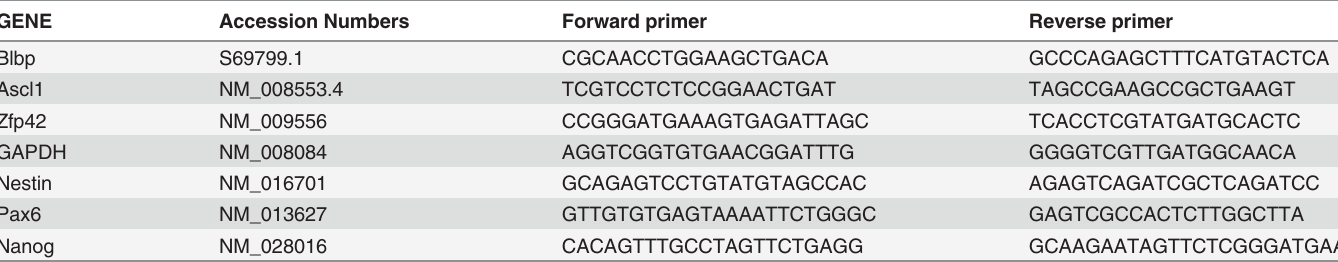
Table 1. Primers used for QRT-PCR